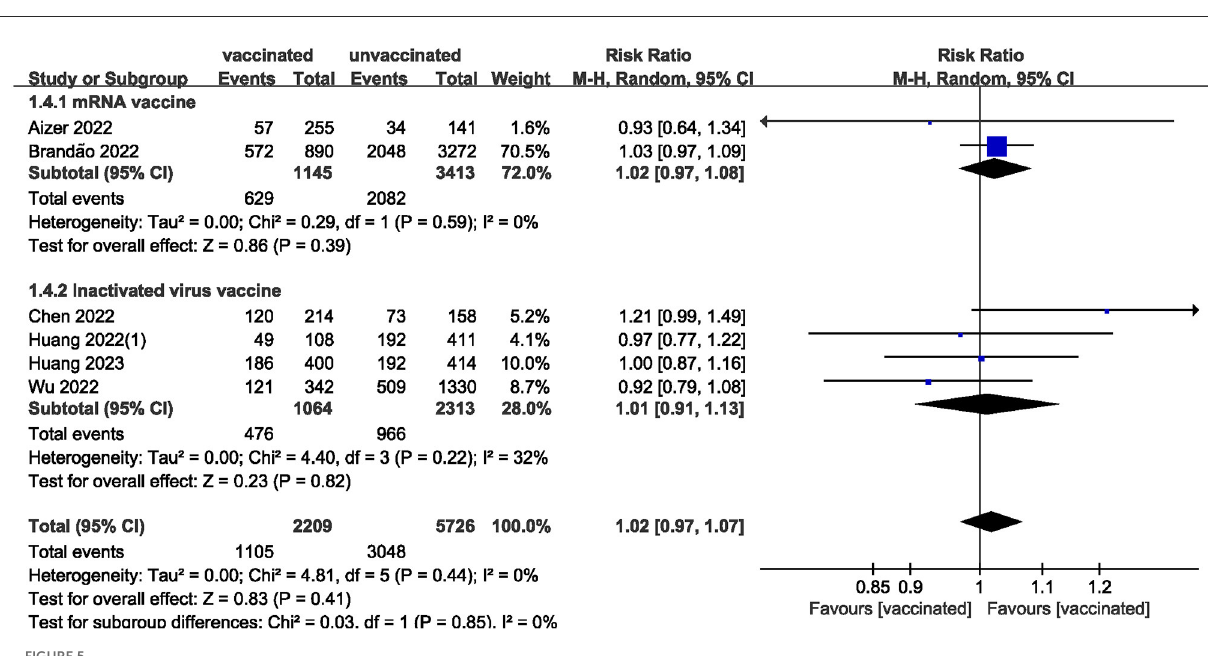
FIGURE5 Forest plot of implantation rate for vaccinated vs. unvaccinated.